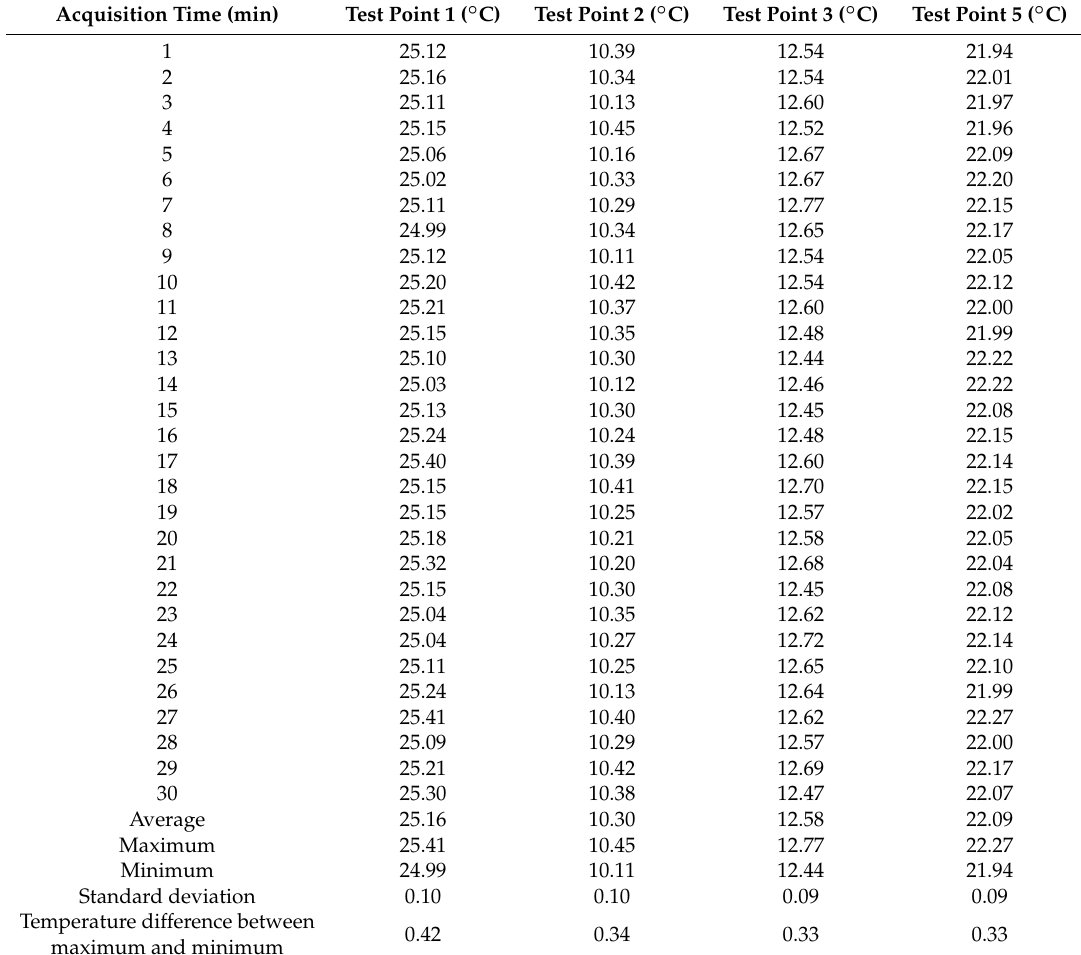
Table 1. Temperature of four test points at 25 ◦ C, 50%, 0.1 m 3 /s.